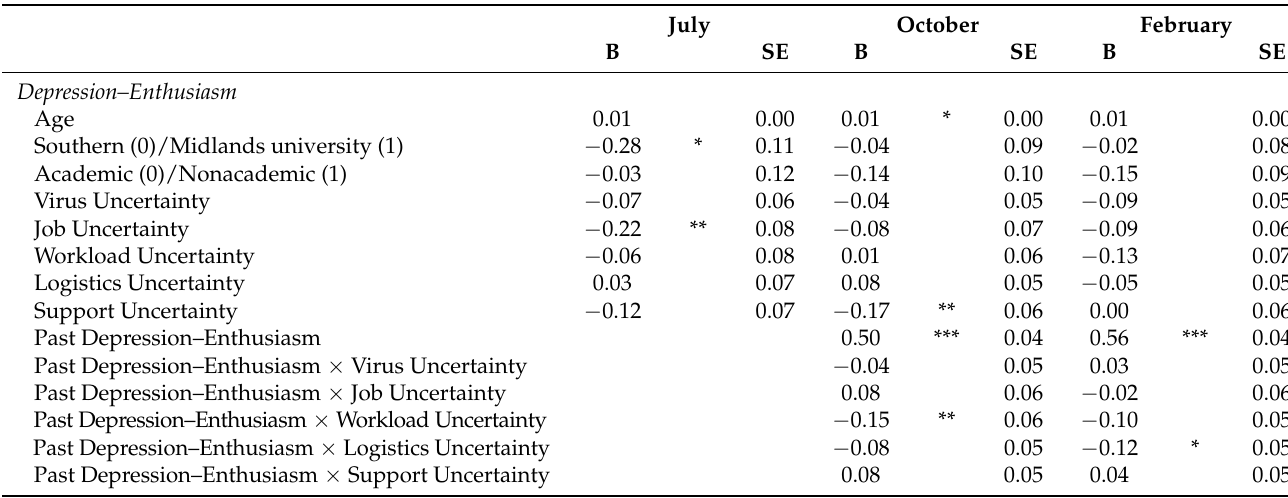
Figure 2. ( A , B ) Interaction effects between past depression–enthusiasm and uncertainty. 6.5. Testing Research Question 1 The relative weights analysis confirmed that all five uncertainty variables contribute to both anxiety–contentment and depression–enthusiasm (Table 7). In particular, the form of uncertainty that seems to have the most substantial impact across all data waves is employer support uncertainty, with job uncertainty following closely behind. There was a steep drop-off in the relative impact of virus uncertainty after the first data wave.